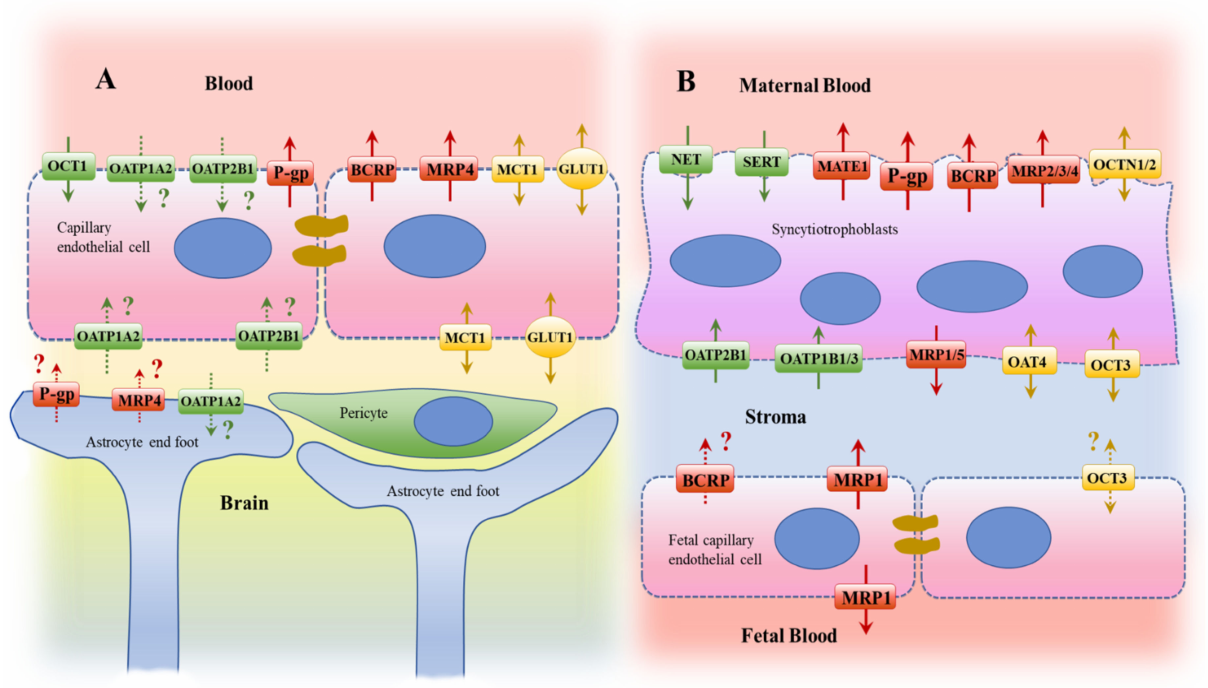
Figure 1. Overview of transporters expressed in the blood–brain barrier ( A ) and the blood–placental barrier ( B ). ABC transporters are represented in red, unidirectional SLC are represented in green and bidirectional SLC are represented in yellow. Arrows indicate the direction of the transport. Dotted arrows with a question mark indicate that the transporter localization requires